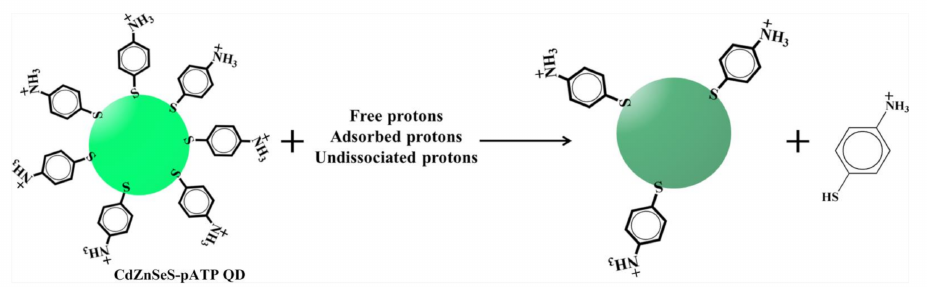
Scheme 3. The schematic diagram of the mechanism of fluorescence response of CdZnSeS-pATP QDs to paper